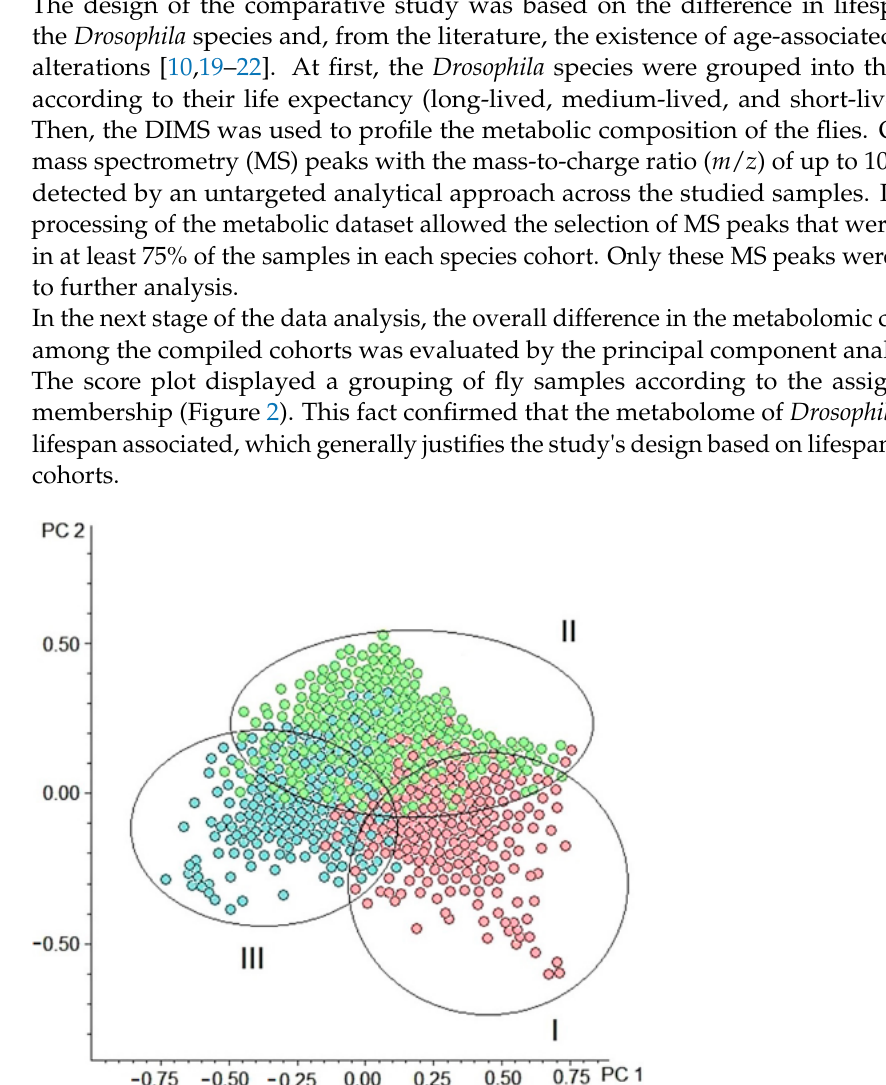
Figure 2. Principal component analysis (PCA) score plot (PC1 vs. PC2) of metabolomic profiling data. ( ● ) Samples from the cohort of the long-lived species (group I), ( ● ) samples from the cohort of the medium-lived species (group II), and ( ● ) samples from the cohort of the short-lived species (group III). The first two principal components (PC1 and PC2) explain about 70% of the total varia- tion in the